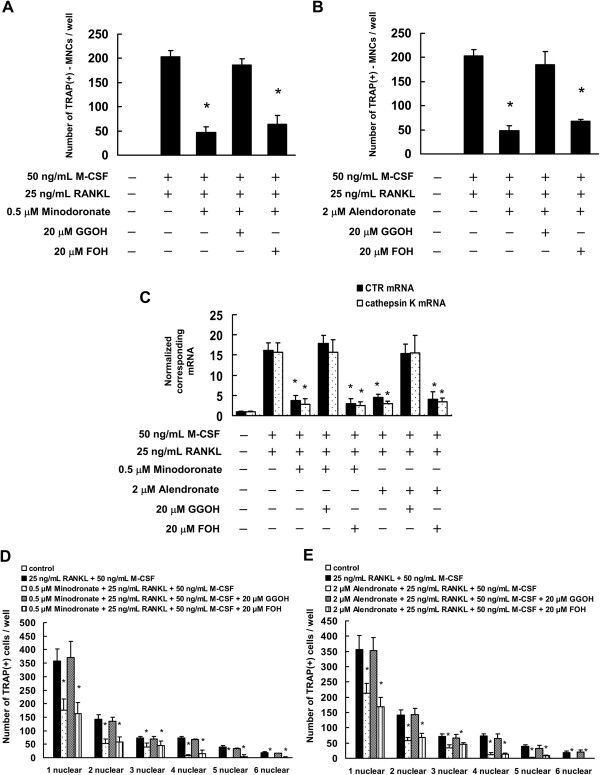
Minodronate and alendronate inhibited osteoclast formation via suppression of GGPP biosynthesis in C7 cells. C7 cells were pretreated with 20 μM FOH or 20 μM GGOH for 4 h and were then treated with 0.5 μM minodronate or 2 μM alendronate and 25 ng/mL RANKL plus 50 ng/mL M-CSF for 12 days. Cultures were fed every 3 days by replacing with 500 μL of fresh medium, with or without minodronate, alendronate, RANKL, M-CSF, FOH, and GGOH. (A, B) Inhibitory effect of mevalonate pathway intermediates FOH or GGOH on the inhibition of osteoclast formation by minodronate (A) and alendronate (B). Cultures were fixed and stained for TRAP-positive multinucleated cells, and the number of cells per well was counted. These results are representative of 5 independent experiments. *P < 0.01 compared to 25 ng/mL RANKL plus 50 ng/mL M-CSF administration. (C) CTR and cathepisin K mRNA expression in C7 cells that were treated with minodronate or alendronate along with FOH or GGOH. Total RNA was extracted, and the CTR and cathepsin K mRNA levels were determined by real-time PCR. The results are expressed as the ratio of treated to control samples after normalization to GAPDH mRNA levels. The results are representative of 4 independent experiments. *P < 0.01 compared to 25 ng/mL RANKL plus 50 ng/mL M-CSF administration. (D, E) Cultures were fixed and stained for TRAP-positive cells, and the number of cells per well was counted. These results are representative of 4 independent experiments. *P < 0.01 compared to 25 ng/mL RANKL plus 50 ng/mL M-CSF administration.